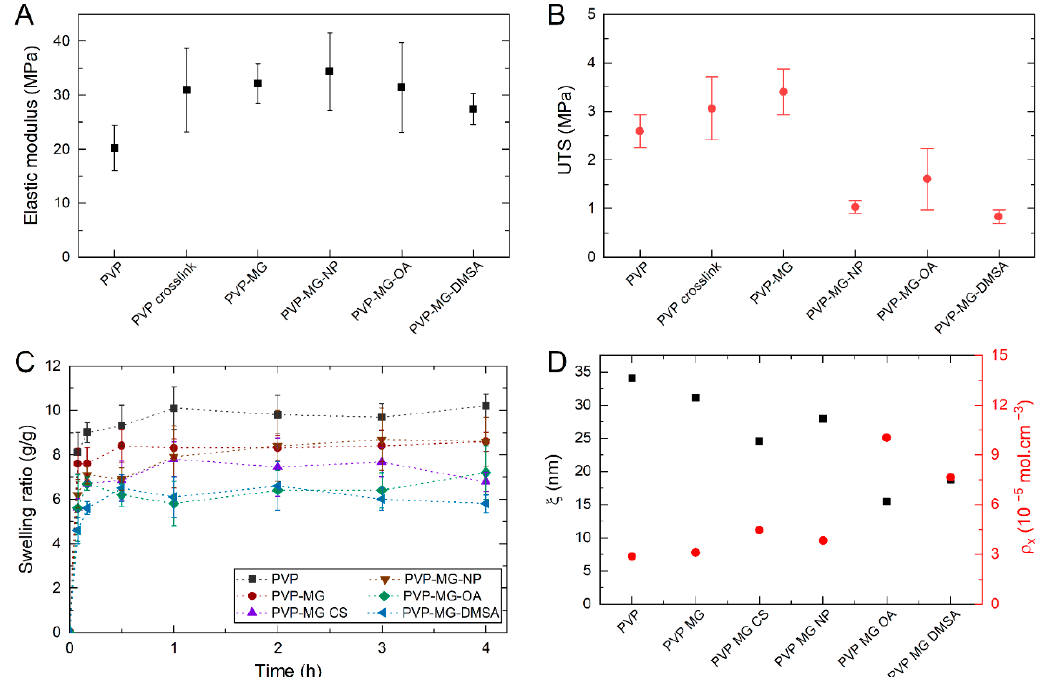
Figure 6. Mechanical parameters of the produced membranes before crosslinking (PVP), after crosslinking (PVP crosslink) and containing 10 wt.% PNIPAAm microgels (PVP-MG): Young’s modulus— E ( A ) and ultimate tensile strength—UTS ( B ). ( C ) Swelling behavior, and ( D ) mesh size ( ξ ) and crosslinking degree ( ρ x ) of the produced PVP membranes without and with PNIPAAm microgels (MG). (PVP-MG CS: PVP membrane containing PNIPAAm microgels with chitosan; PVP-MG-NP: PVP membrane containing PNIPAAm microgels with bare Fe 3 O 4 NPs; PVP-MG-OA: PVP membrane containing PNIPAAm microgels with Fe 3 O 4 NPs coated with oleic acid; PVP-MG-DMSA: PVP membrane containing PNIPAAm microgels with Fe 3 O 4 NPs coated with dimercaptosuccinic acid).